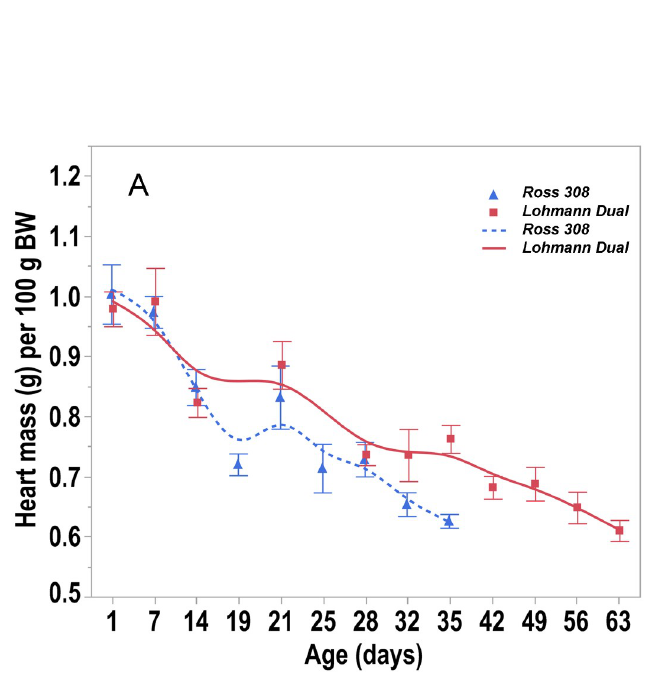
Fig 6. Trendlines of the changes in relative heart mass versus day post hatching. Bars refer to mean ± standard error of the mean of the chicken samples at each time interval.